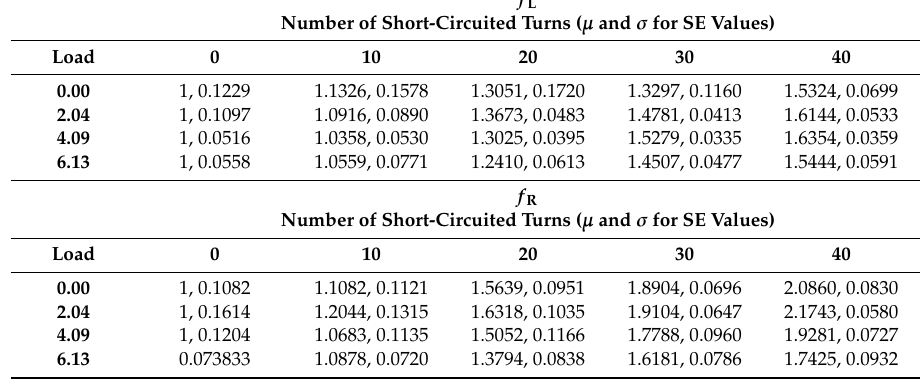
Table 1. μ and σ for SE values. Table 1. µ and σ for SE